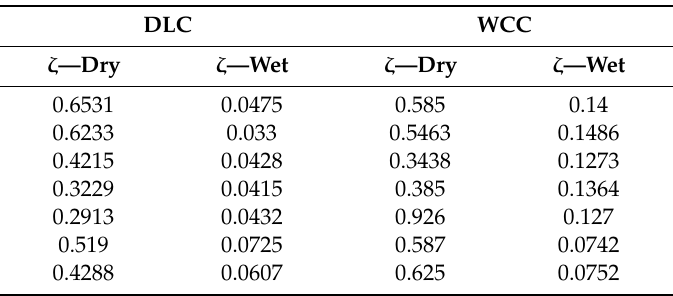
Table 2. Friction coe ffi cient and ζ measurements of coatings.